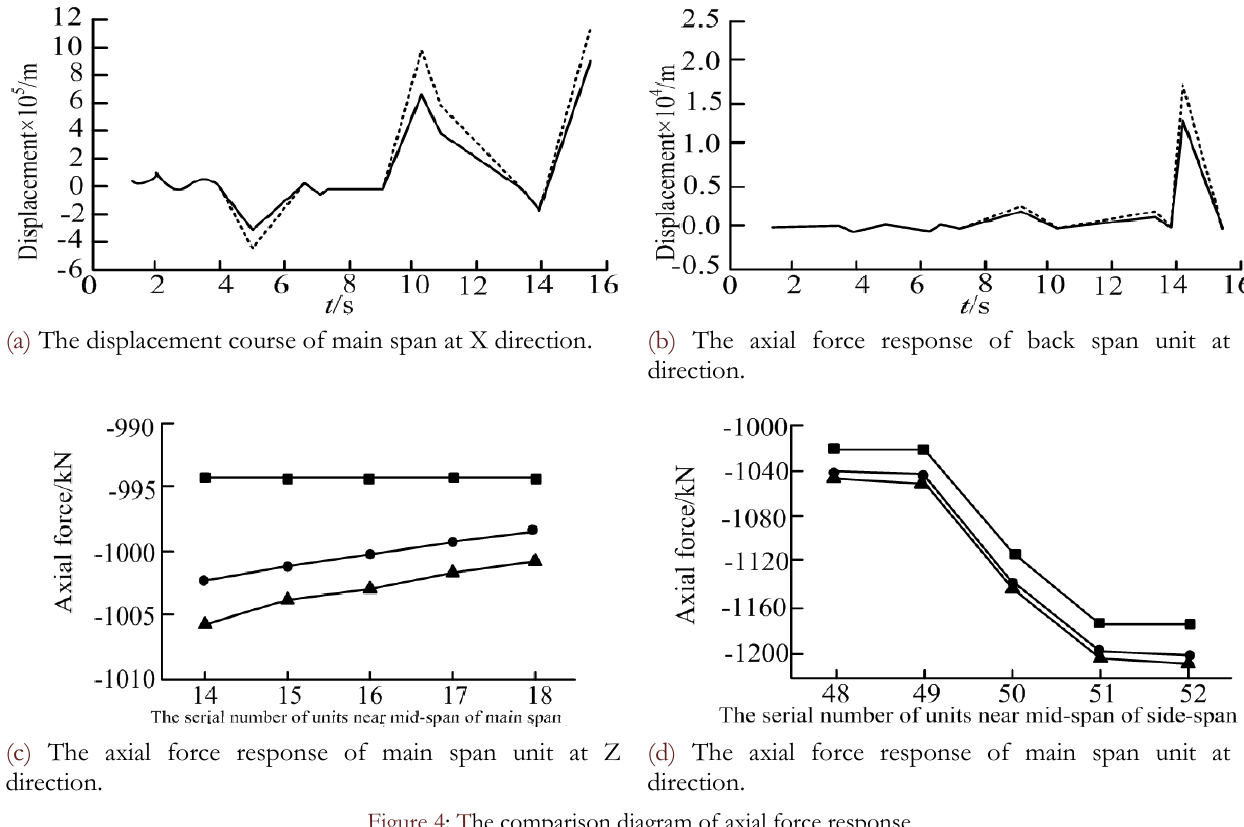
Figure 4: The comparison diagram of axial force